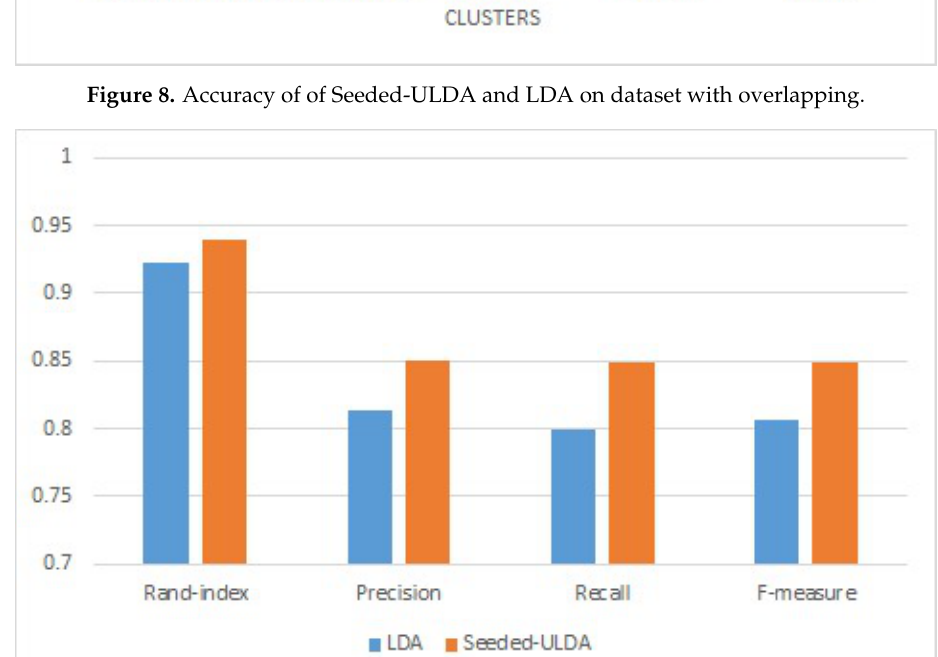
Figure 9. Performance of Seeded-ULDA and LDA by Rand-index, precision, recall and F-measure on dataset with